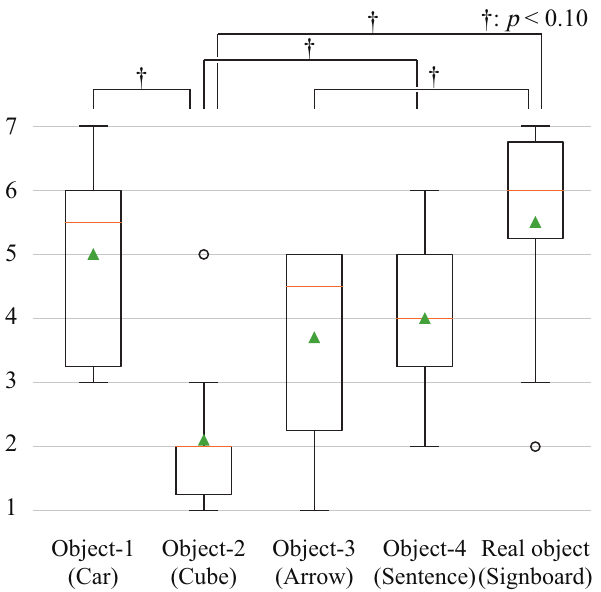
Figure 8. The result of Question-A: Did you feel that the object blended with the surroundings?